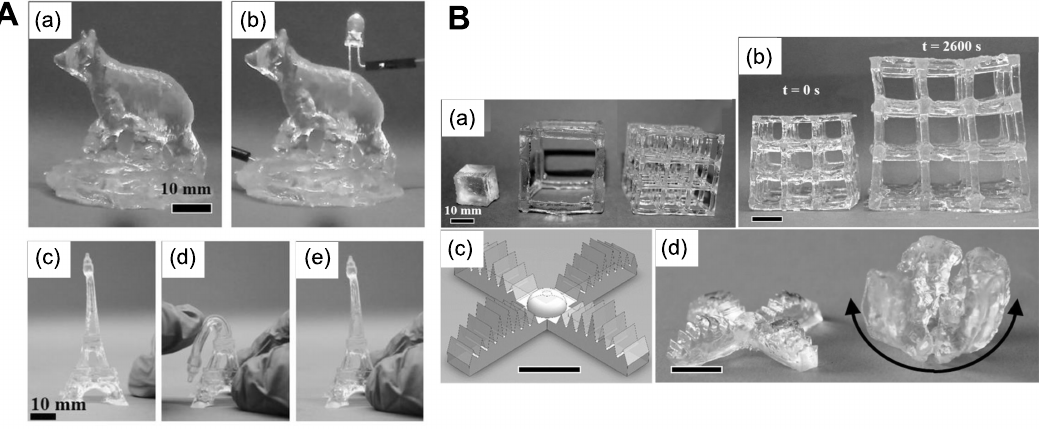
Figure 14. Highly elastic, transparent, and conductive 3D printed ionic composite hydrogels. ( A ) ( a ) 3D printed transparent, conductive ionic composite hydrogel bear, ( b ) a light-emitting diode (LED) lights up when electric potential is applied across the object, and ( c – e ) demonstration of resilience of a 3D printed Eiffel tower after repeatable extensive deformation. ( B ) ( a ) Printed ionic composite of different surface area/volume ratios with different swellings, ( b ) a high-surface area/volume ratio ionic composite hydrogel before and after water absorption, ( c ) design of a multi-armed hydrogel gripper, ( d ) before and after swelling in blue dyed water. Reproduced with permission from